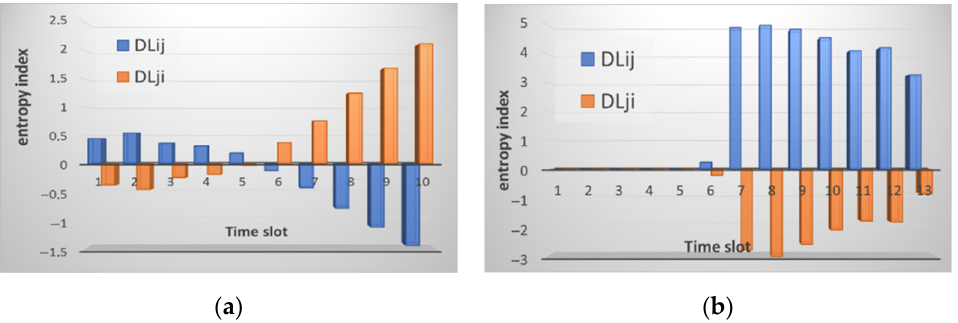
11 of 19 Figure 5. Result of calculating the entropy for the level of CPU utilization by node i relative to node j (marked in blue) and by node j relative to node i (marked in orange). 3.2. Analysis of Node Behavior with Additional Payload When providing an additional payload that is not an attack, some changes were ob ‐ served in the sensory system. An additional payload was that the node sent echo requests using the ping command. Figure 6 shows the result of calculating the normal distribution function for the incoming traffic of a node on which an additional payload is rendered and a node that is operating normally. ( a ) ( b ) Figure 6. The result of calculating the normal distribution function for incoming traffic of: ( a ) node